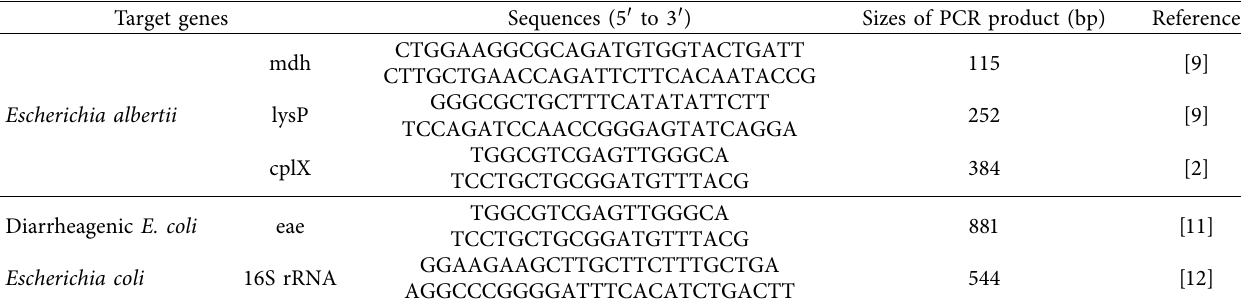
Table 1: PCR primers used in this